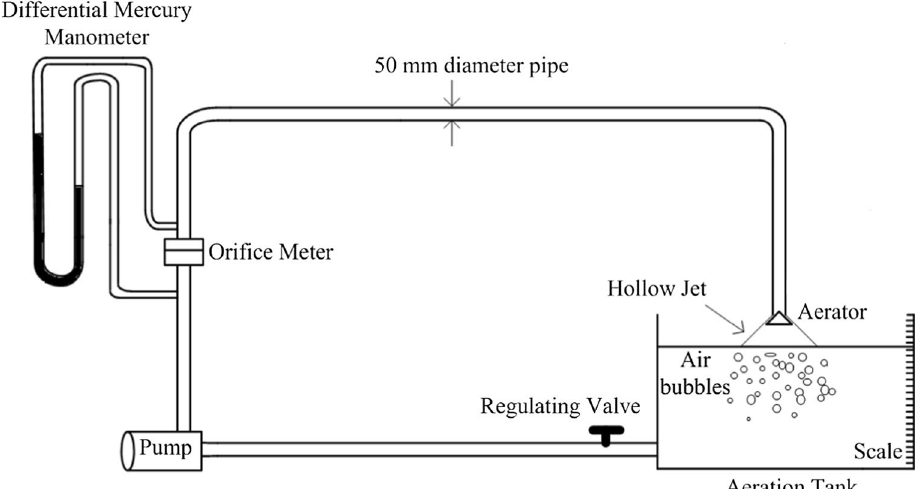
Fig. 2 Experimental